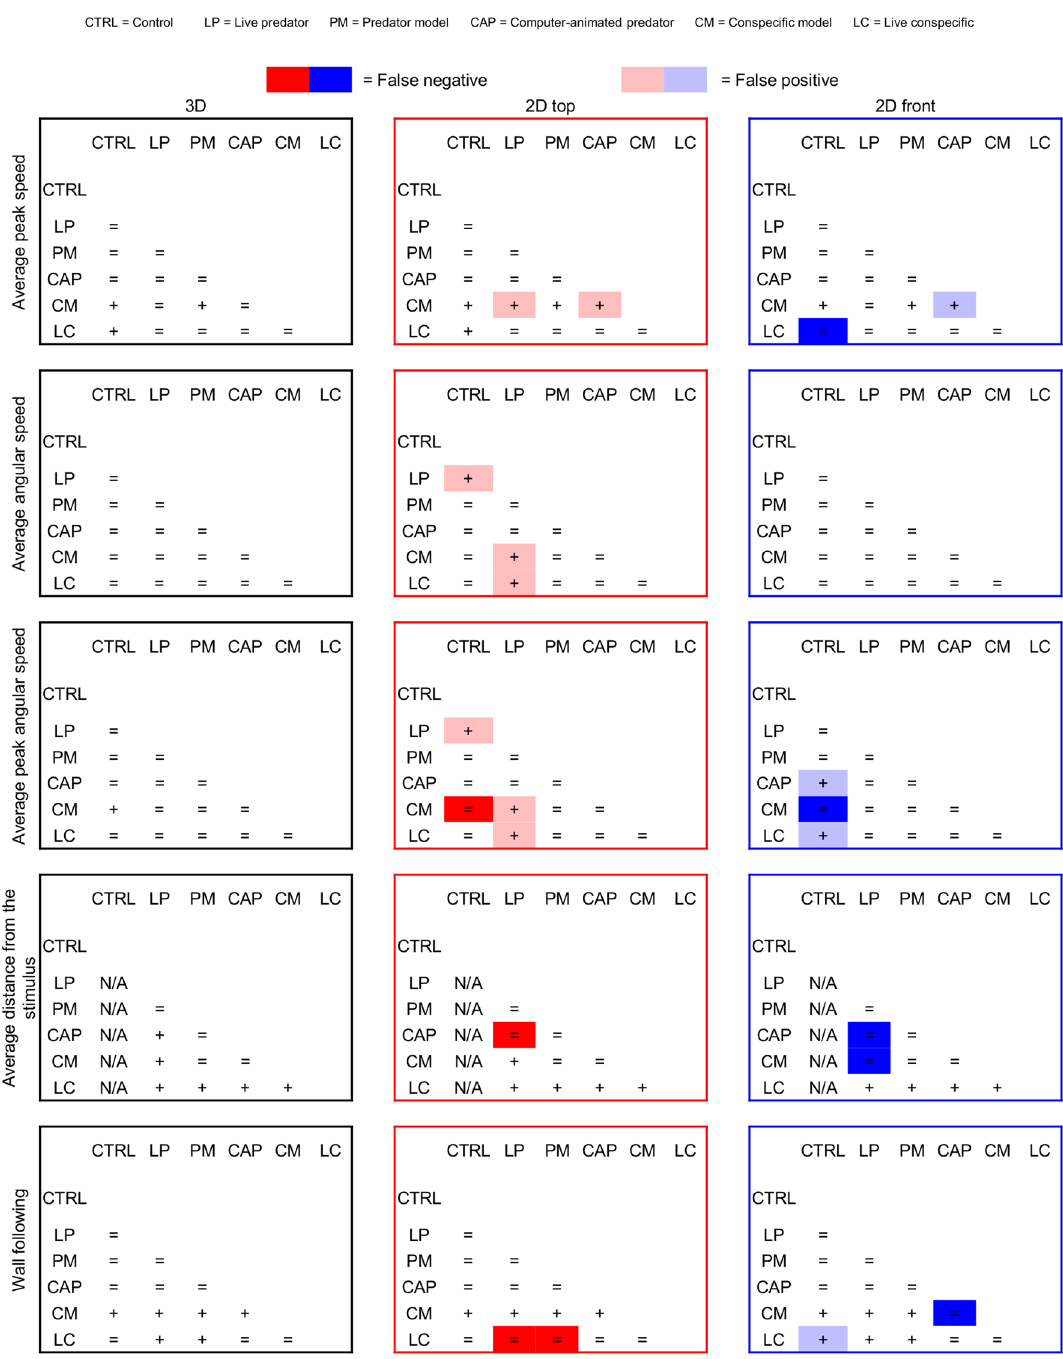
Figure 3. Synopsis of the condition x scoring method interactions demonstrating that differences between conditions vary depending on the scoring method. Repeated measures ANOVA comparisons for average peak speed, average angular speed, average peak angular speed, average distance from the stimulus, and wall following for each of the six experimental conditions, with data collected using 3D reconstruction (black panels), 2D top (red panels), and 2D front (blue panels) views. The statistical model was a repeated measures ANOVA for split-plot designs with condition (CTRL, LP, PM, CAP, CM, LC) as between-subject factor and scoring method (3D, 2D top, and 2D front) as within-subject factor. We observed significant interactions between condition and scoring method in all the following parameters: average peak speed (n = 90; F 10,168 = 2.131, p < 0.05); average angular speed (n = 90; F 10,168 = 4.209, p < 0.001); average peak angular speed (n = 90; F 10,168 = 4.260, p < 0.001); average distance from the stimulus (n = 80; F 8,150 = 11.026, p < 0.001); wall following (n = 90; F 10,168 = 6.305, p < 0.001) respectively. + symbols indicate significant differences in post-hoc comparisons (p < 0.05 in Tukey’s HSD) between the corresponding conditions in each contingency table. Dark red and blue boxes highlight false negative results, and light red and blue boxes highlight false positive results using 3D data as ground truth